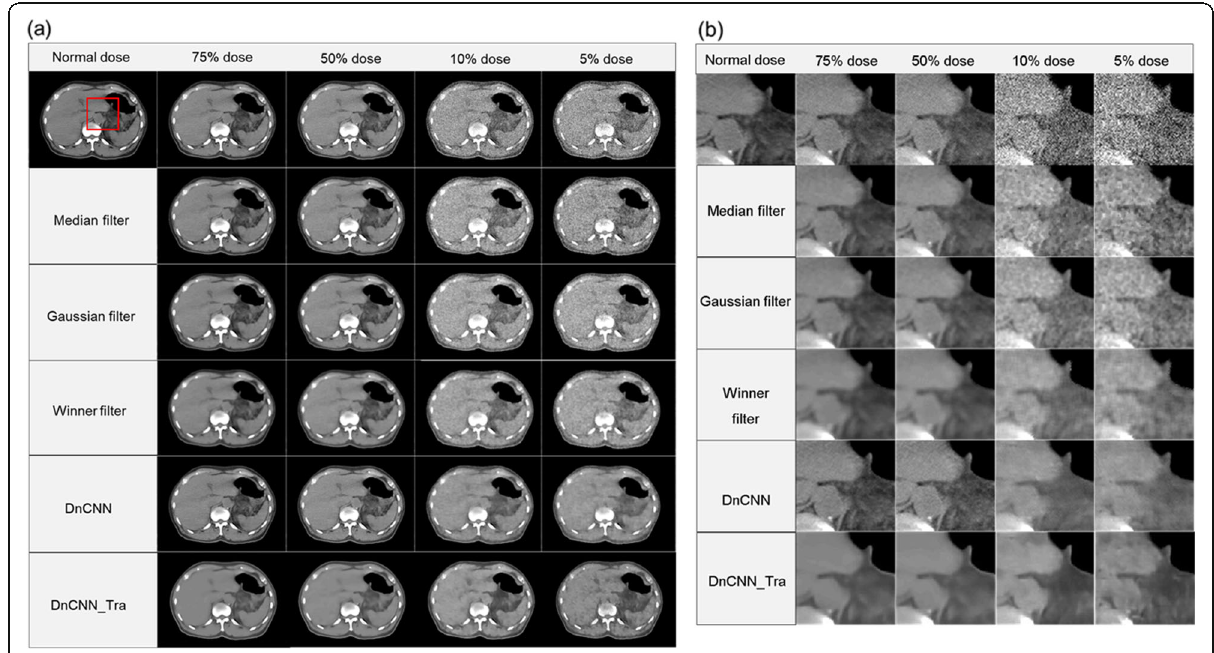
Fig. 3 Denoised image with contaminating noise artifacts, which was simulated to minimize dose exposure in the image at four different dose levels. a Results of noise reduction in the entire abdominal image; b Enlarged images of the region indicated by the red region of interest; all images are presented with the same window width and level. Median, Gaussian, Wiener, original DnCNN, and optimized DnCNN (DnCNN_Tra) techniques were applied for noise reduction at each dose-reduction